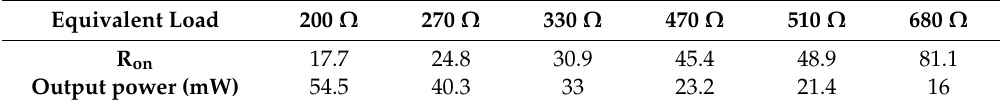
Table 4. Output power and Ron value under different loads.